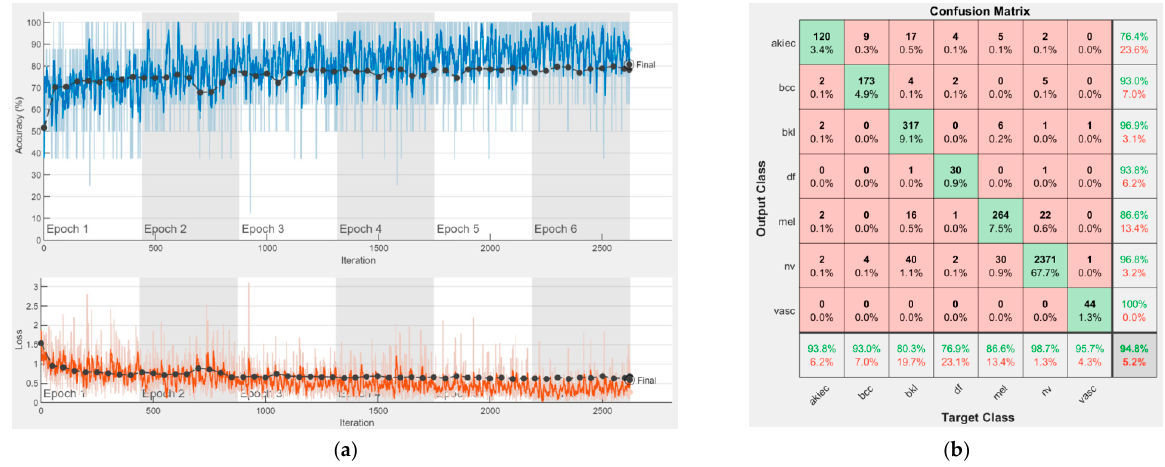
Figure 14. Results using MobileNet-V2, ( a ) Accuracy and loss, ( b ) Confusion matrix.